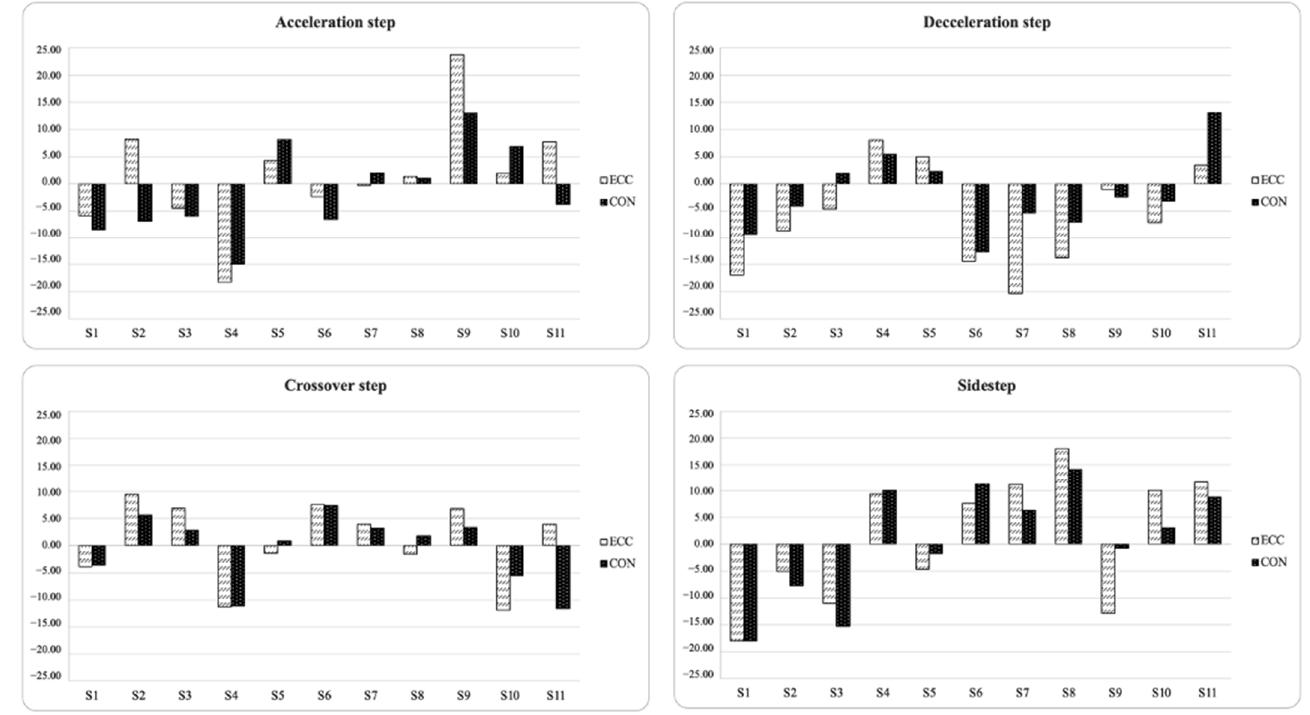
Figure 4. Percentage of asymmetry index (ASI) for each participant and task (positive = right leg dominance; negative = left leg dominance).